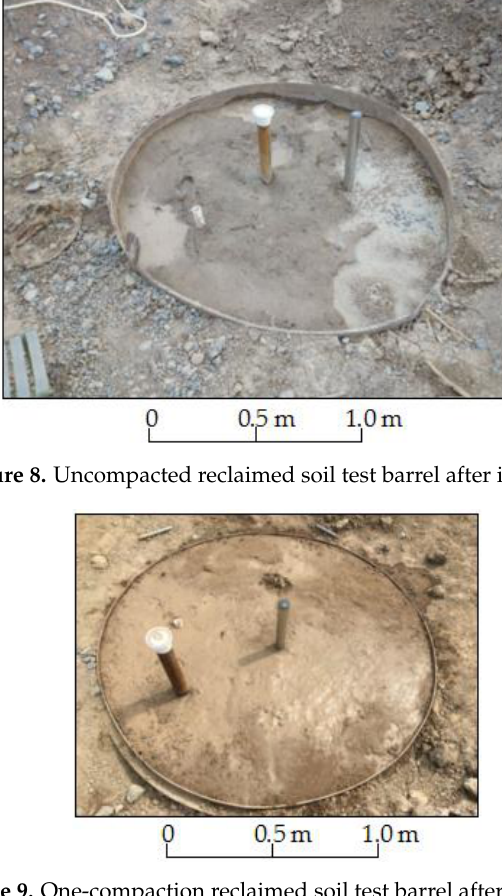
Figure 9. One-compaction reclaimed soil test barrel after irrigation.